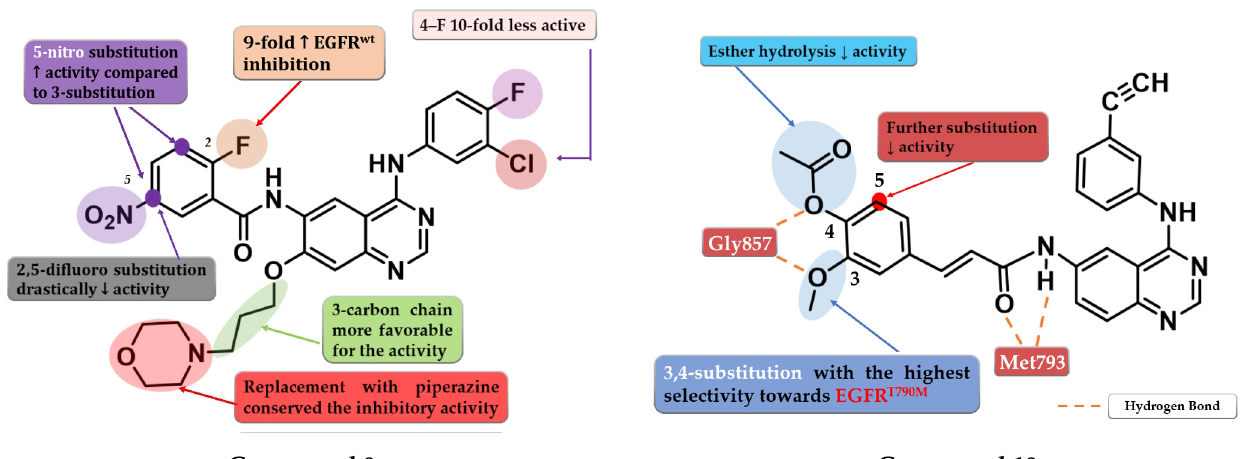
Figure 7. Structure–activity relationship of compound 9 as reported by Hou et al. [113]; structure– activity relationship and molecular docking of compound 10 in the human EGFR T790M kinase domain (PDB ID 2JIU) [115], as reported by Zhang et al. [114].